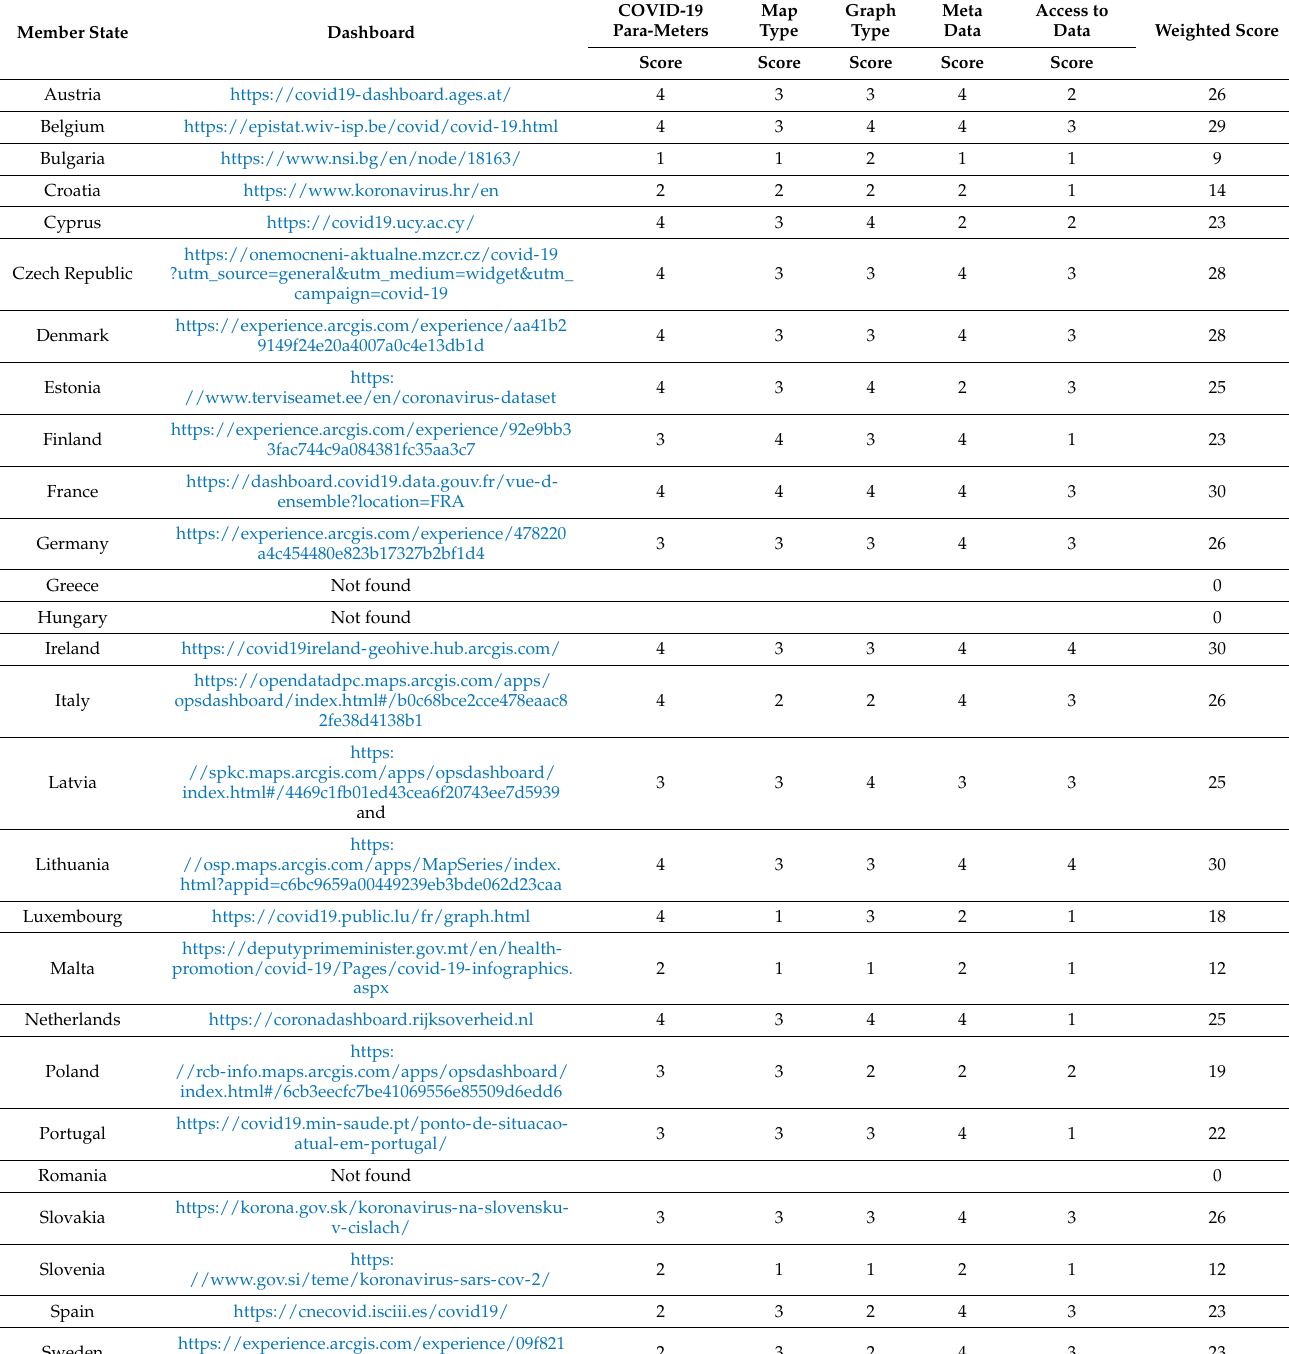
Table 4. Results multicriteria evaluation COVID-19 dashboards from EU Member States in February 2021. Member